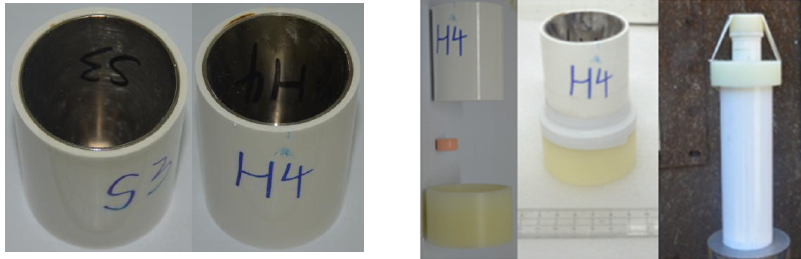
Figure 7. Photographs of the liners and shaped charges: ( a ) the liners, ( b ) the shaped charges, and ( c ) the assembly relationship and location of the shaped charges. Table 5. Parameters of the shaped charges.